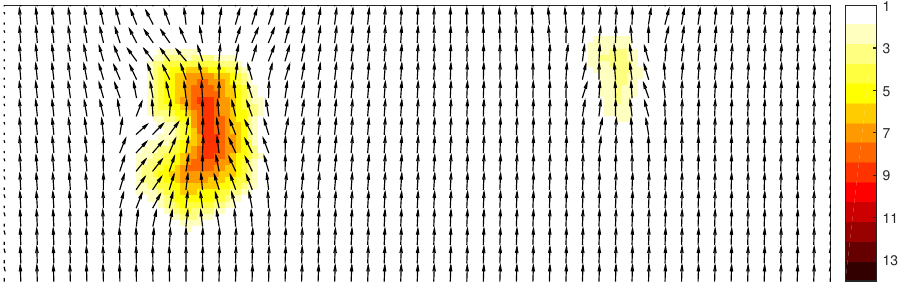
Figure 7. Spatial distribution of total variance (in m 2 ) and vector plot of mean wave direction obtained with scheme FDM-flux.